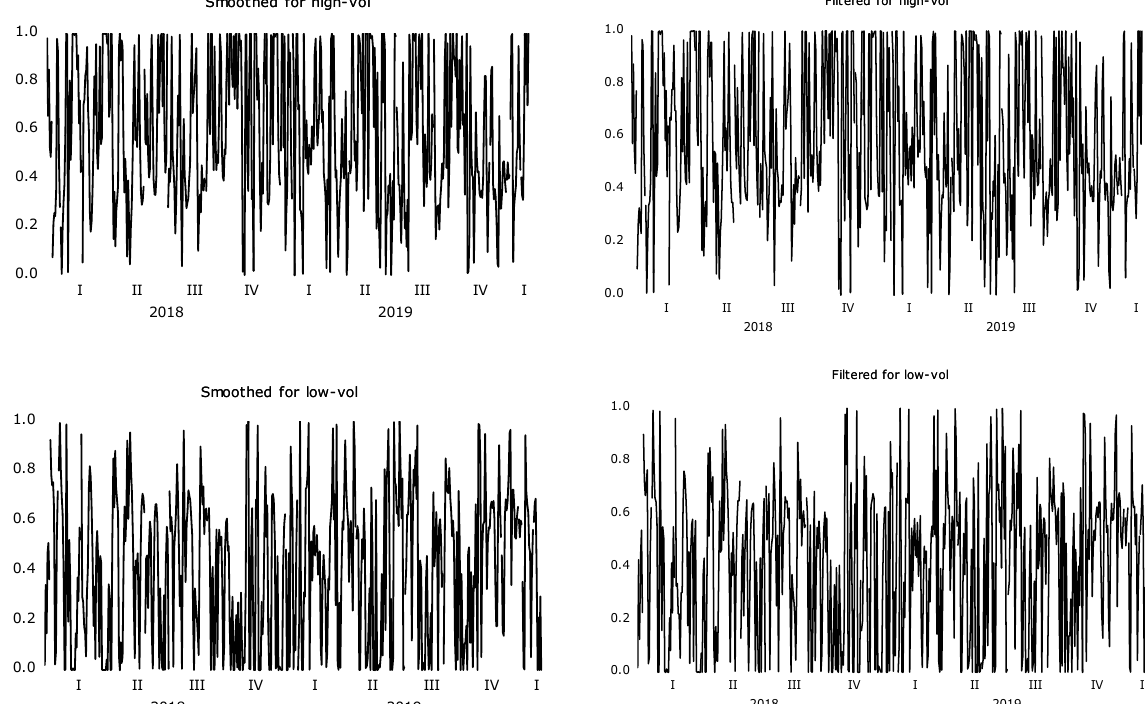
0.0 Figure 9. Computed smoothed probabilities and filtered conditional volatilities for SOXX.